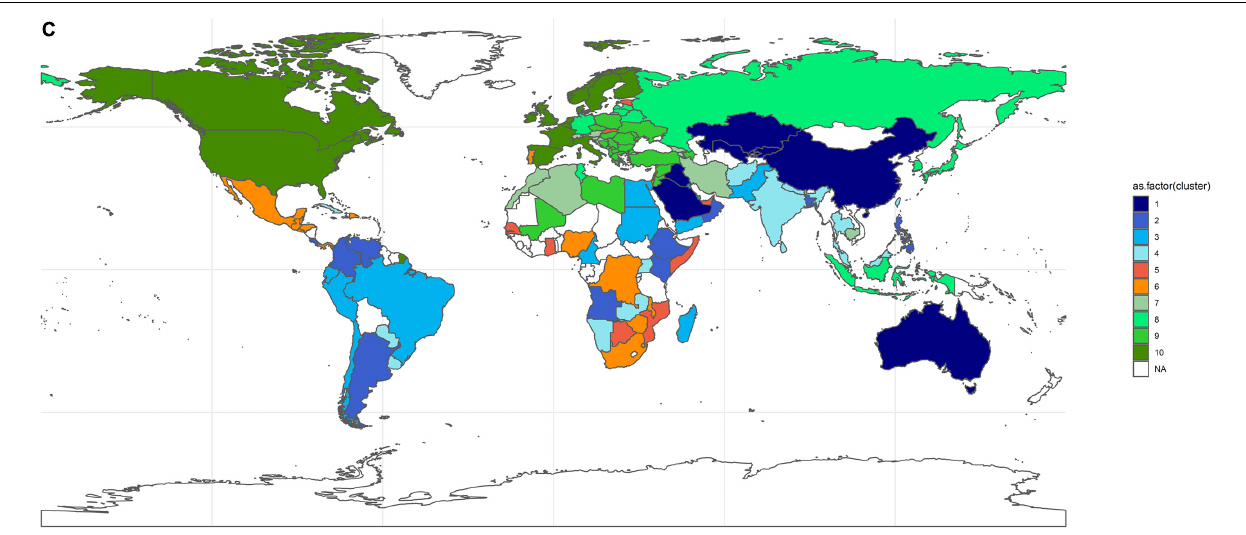
FIGURE 1 | Patterns of incidence curves of SARS-CoV-2-associated deaths according to countries. (A) Hierarchical clustering of incidence curves of SARS-CoV-2-associated deaths per country. (B) Major patterns of incidence curves of SARS-CoV-2-associated deaths defined based on hierarchical clustering, and the example of one country for each pattern. Patterns of incidence curves of SARS-CoV-2-associated deaths are shown in 10 panels numbered from 1 to 10; these numbers correspond to those from the cladogram of panel (A) . The example of one country is shown in a panel at the right of each of the ten patterns. X -axis indicates time in numbers of days, and Y -axis indicates normalized daily deaths. (C) Worldwide distribution of the 10 major patterns of incidence curves of SARS-CoV-2-associated deaths defined based on hierarchical clustering. Colors are as used for panel (A) .